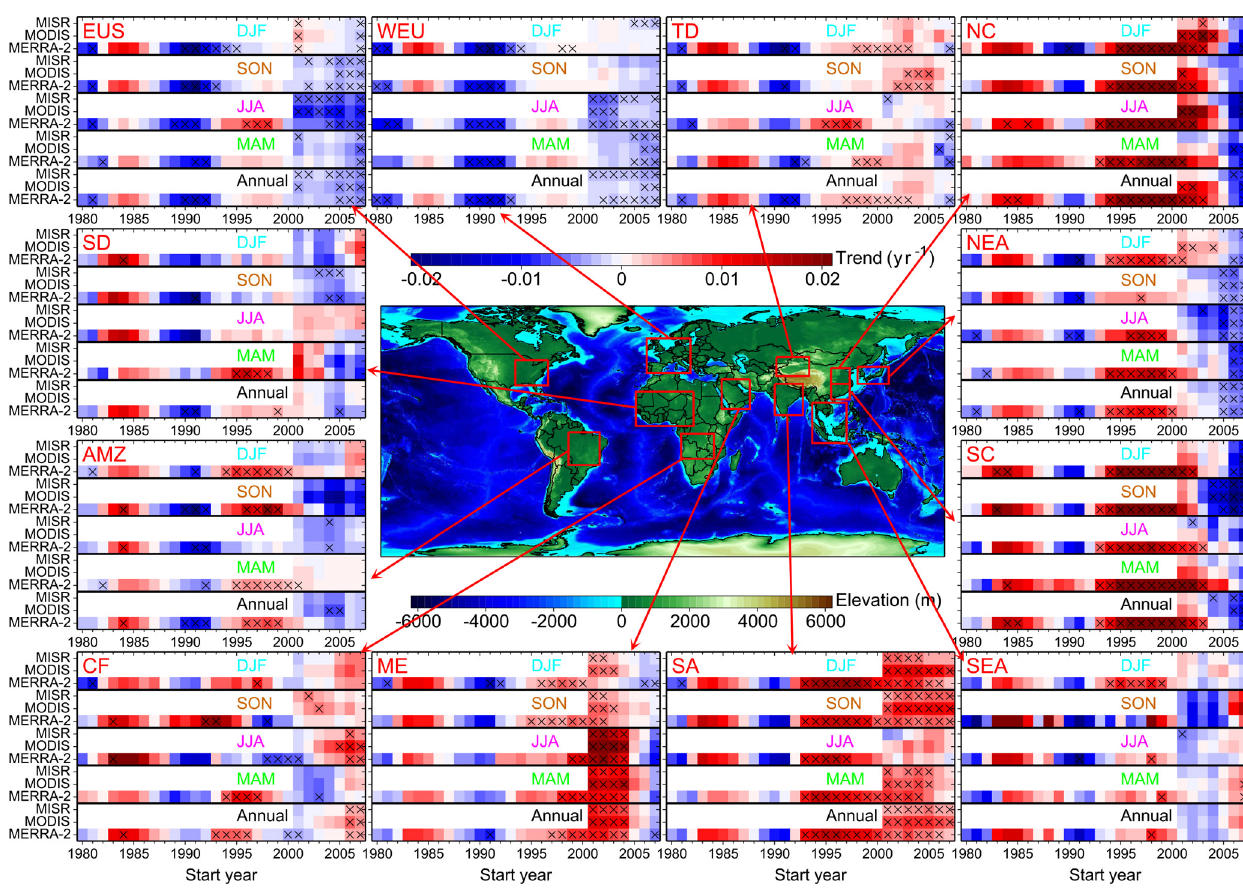
Figure 10. Temporal evolution of sliding decadal trends in the annual and seasonal mean AOD from MERRA-2, MODIS/Terra and MISR over the 12 ROIs. The trends were calculated for each 10-year interval from 1980 to 2007 for MERRA-2 and from 2001 to 2007 for MODIS/Terra and MISR. The colors of the rectangles represent the intensity of the decadal trend (units: yr − 1 ) and those with black “x” signs indicate linear trends above the 95% significance